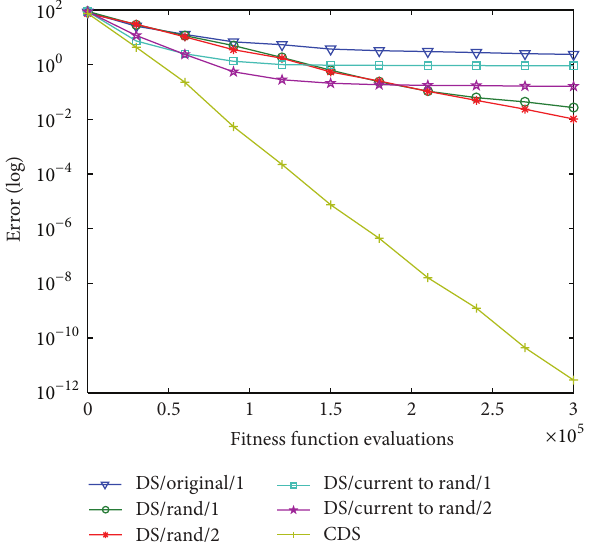
Figure 6: Comparison of performance of six algorithms for mini- mization of 𝑓 07 with dimension